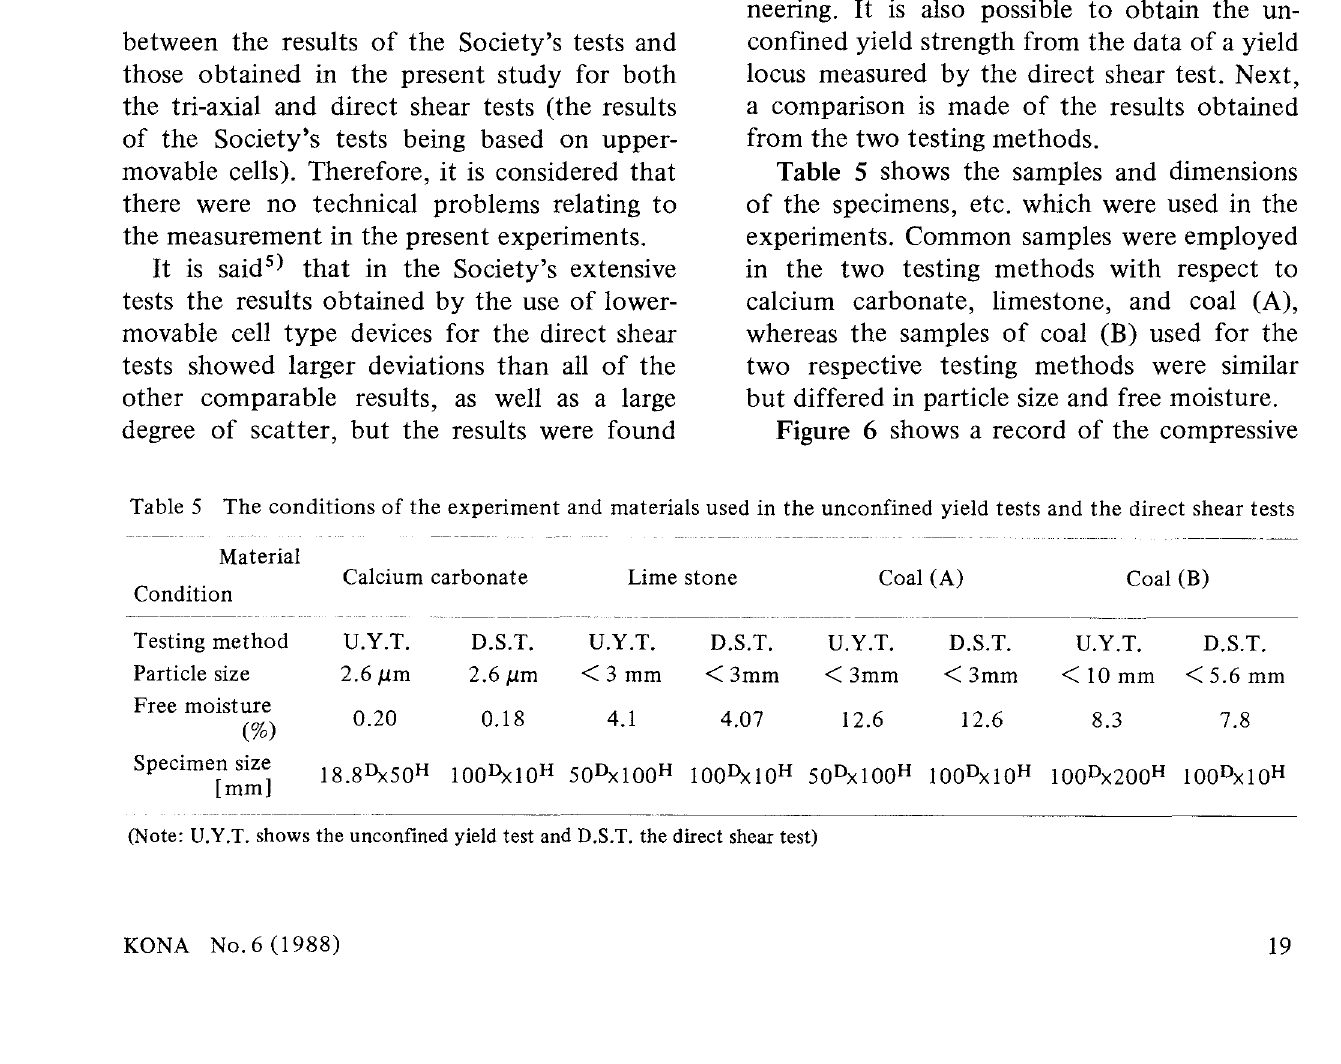
Fig. 5 A comparison of the angle of internal friction for Onahama sand and Toyoura sand measured by various types of shear testers